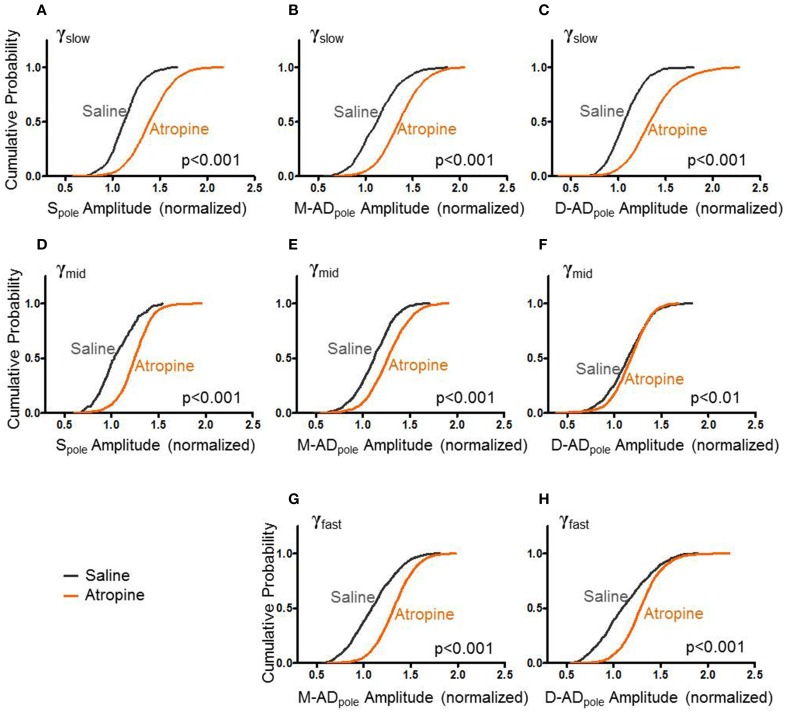
Atropine increases amplitude of CSD for all bands at all sites. (A–C) With respect to saline-control, atropine significantly increased the amplitudes of Spole, M-ADpole, and D-ADpole respectively of γslow oscillations for all animals (atropine/saline-control, Spole: n = 1875/871 data points from 3/3 mice; M-AD and D-ADpole: n = 2154(M-ADpole), 2192(D-ADpole)/871 data points from 5/4 mice p < 0.001 One-Way ANOVA). (D–F), Similarly for γmid, atropine significantly increased the rmsCSD amplitudes at all locations, though the difference was less at the D-ADpole (atropine/saline-control, Spole: n = 991/175 data points from 3/1 mice and M-ADpole: n = 1755/1054 data points from 5/4 mice p < 0.001; D-ADpole
n = 1755/1054 data points from 5/4 mice p = 0.001–0.01) One-Way ANOVA. (G,H) For γfast oscillations, atropine significantly increased the amplitude of rmsCSD at the M-ADpole and D-ADpole (atropine/saline-control, n = 2671(M-ADpole), 2670(D-ADpole)/1205 data points from 5/4 mice p < 0.001 One-Way ANOVA).